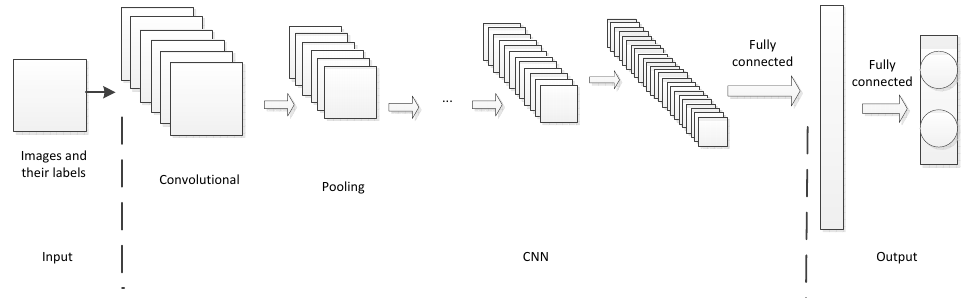
Figure 2. One typical convolutional neural network (CNN)